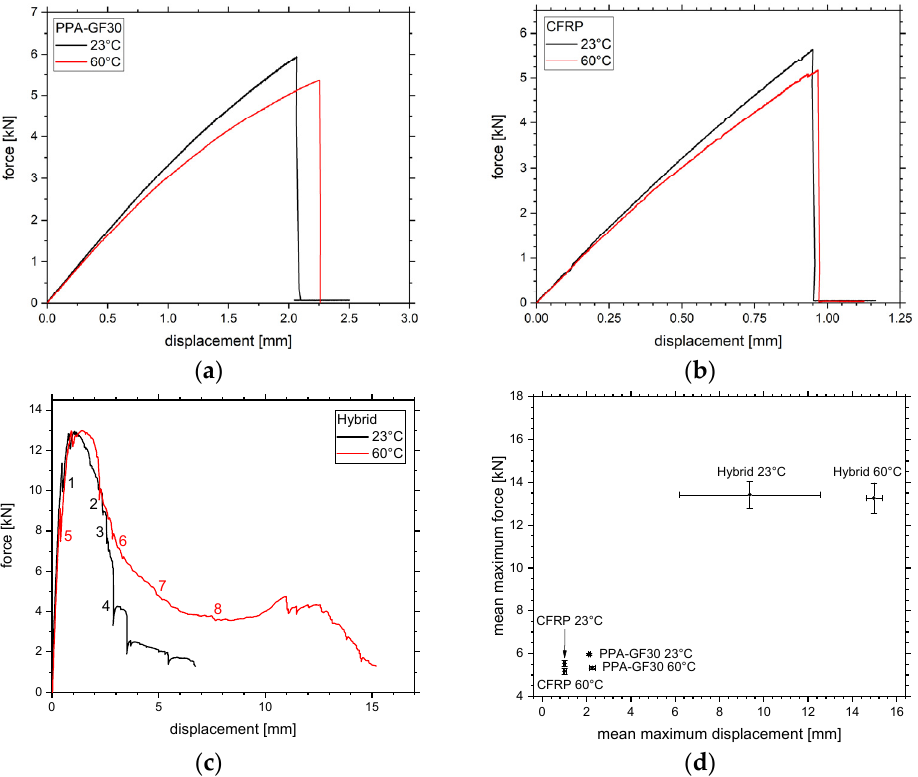
Figure 4. Force-displacement curves of ( a ) PPA-GF30, ( b ) CFRP, ( c ) hybrid specimen, and ( d ) mean maximum values of force over displacement (very small error bars for PPA-GF30 and CFRP). For the hybrid, maximum displacement is reached if F < 0.1 F max . Table 2. Comparative analysis of PPA-GF30 and CFRP specimens at the two different testing tem- peratures.